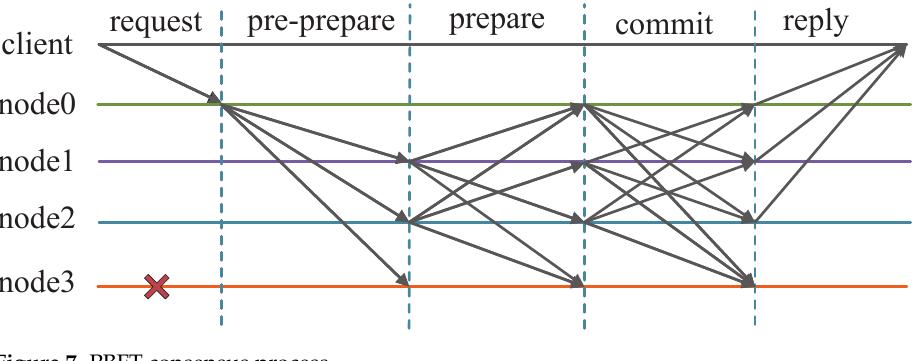
Figure 7. PBFT consensus